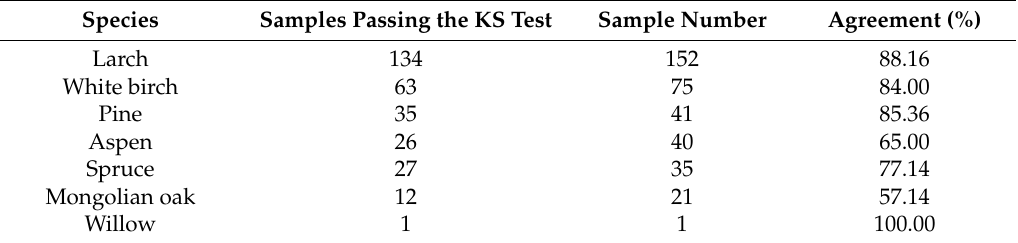
Table 2. The agreement of each species for the two-parameter Weibull diameter distribution using Kolmogorov–Smirnov (KS) test ( p > 0.05).